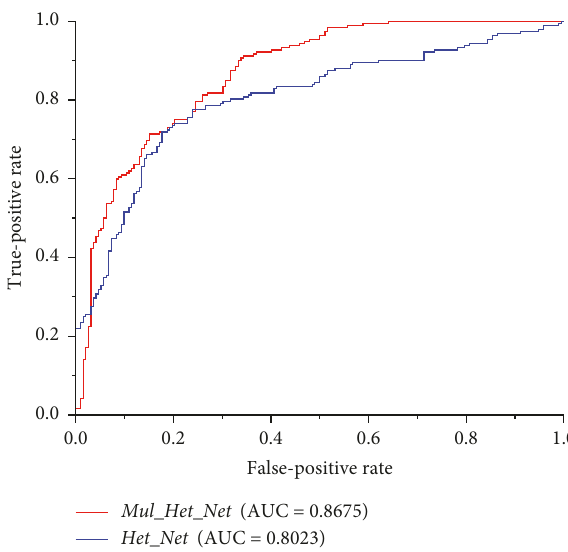
Figure 8: The effect of BRWSP on different networks. Table 1: The known 13 circRNAs for colorectal cancer in the CircR2Disease